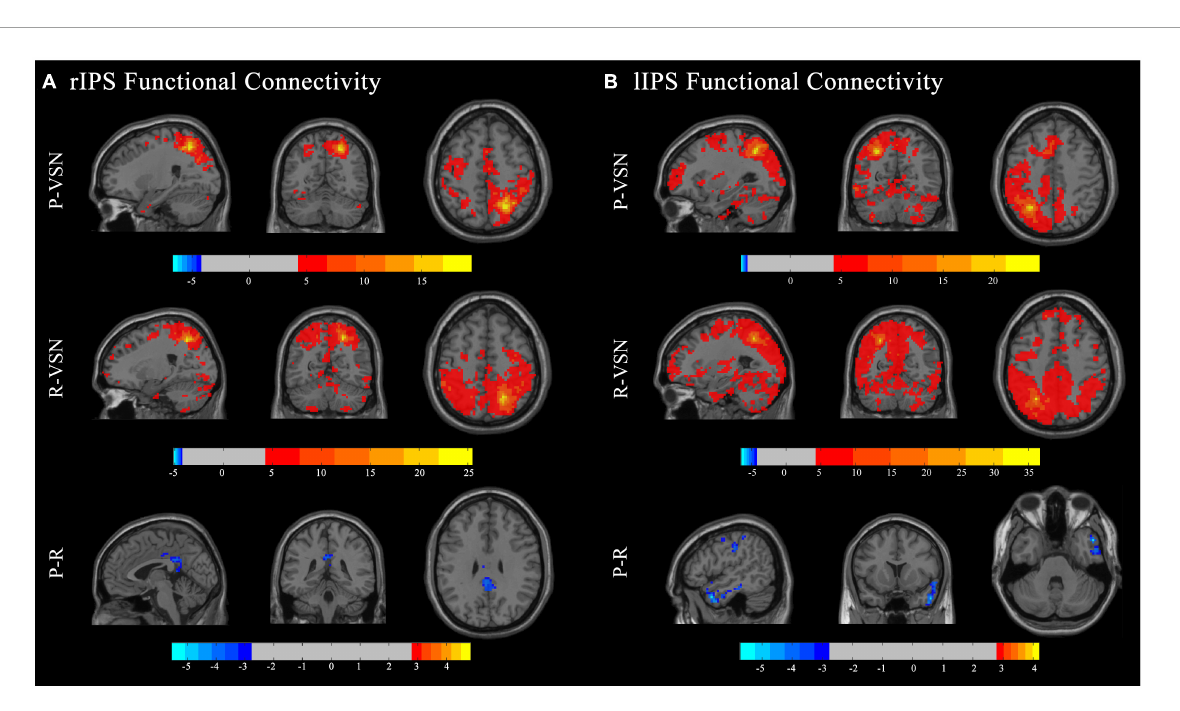
FIGURE4 Functional connectivity (FC) maps. Individual and group comparisons of resting state functional connectivity of seed ROIs rIPS (A) and lIPS (B) . First panel show individual one sample t-test for persistent VSN(P-VSN) ( p < 0.001). Second panel show individual one sample t-test for rapid recovery VSN(R-VSN) ( p < 0.001). Remaining panels show two-sample t-tests comparing persistent VSN with rapid recovery VSN(P-R) ( p <